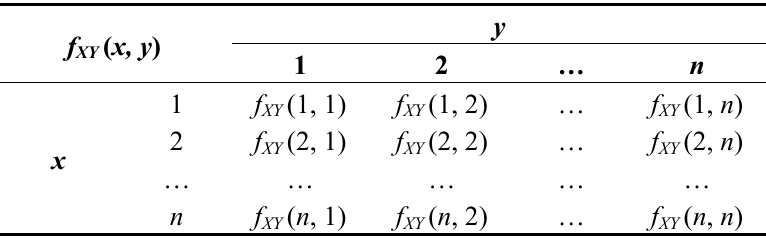
Table 2. Power transition probability